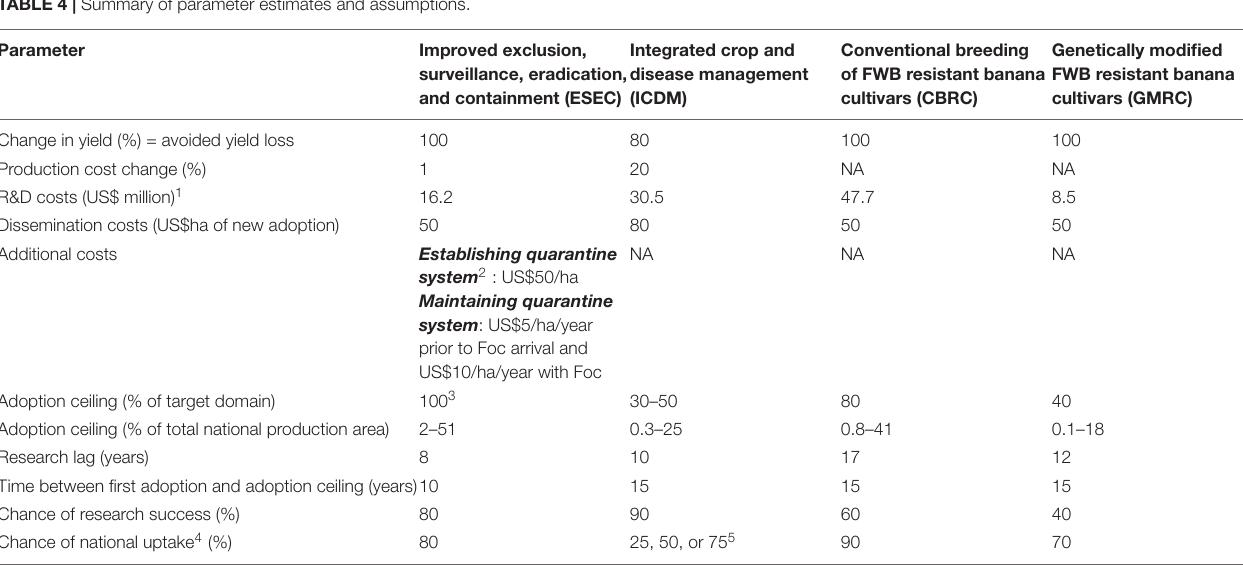
TABLE 4 | Summary of parameter estimates and